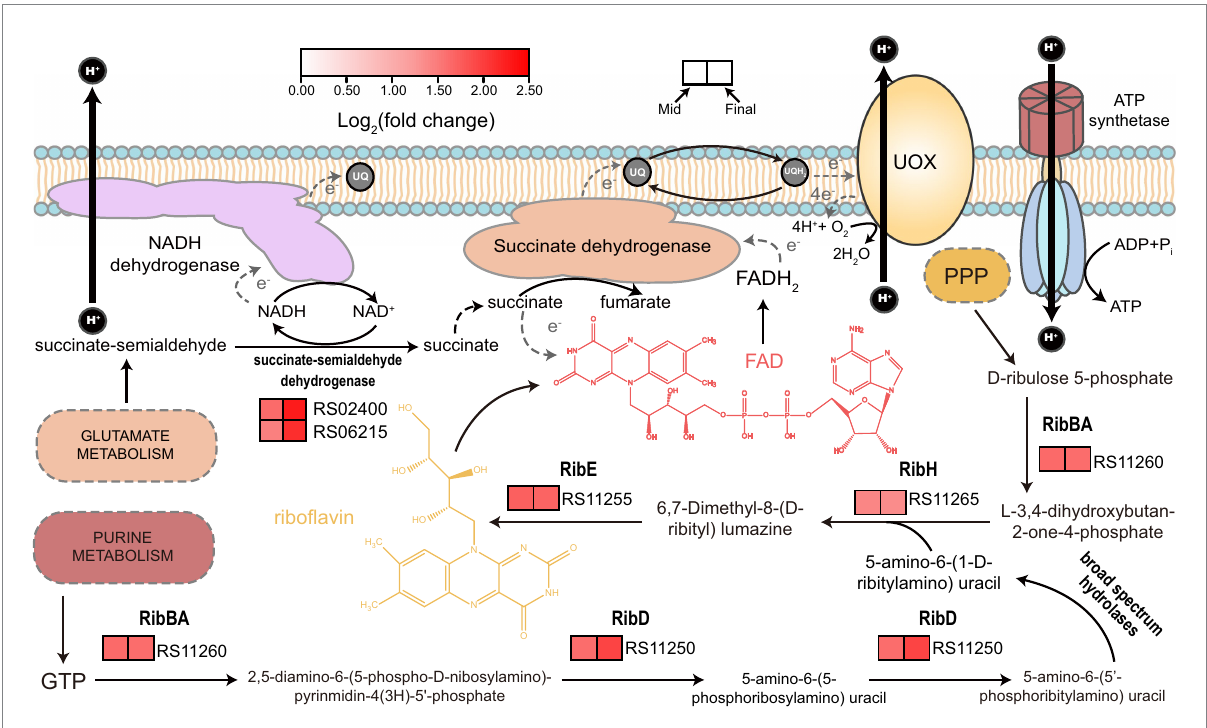
FIGURE 5 Illustration of riboflavin biosynthesis and its relationship to succinate oxidation together with relevant gene expression patterns. GTP from purine metabolism and D-ribulose 5-phosphate from pentose phosphate pathway (PPP) act as the start point of riboflavin biosynthesis. FAD is one of the derivatives of riboflavin and is related to succinate oxidation, which is a part of respiratory chain, as demonstrated in Figure 4. Succinate can be also obtained from oxidation of succinate-semialdehyde in an NAD + -dependent manner, which is also related to glutamate metabolism. Expression patterns (heatmap) with relevant gene ID are shown besides the biochemical reactions catalyzed by the corresponding gene products. Detailed expression data and gene annotations are listed in Supplementary Table S2. RibBA, 3,4-dihydroxy-2-butanone-4-phosphate synthase; RibD, bifunctional diaminohydroxyphosphoribosylaminopyrimidine deaminase; RibE, riboflavin synthase; and RibH, 6,7-dimethyl-8-ribityllumazine